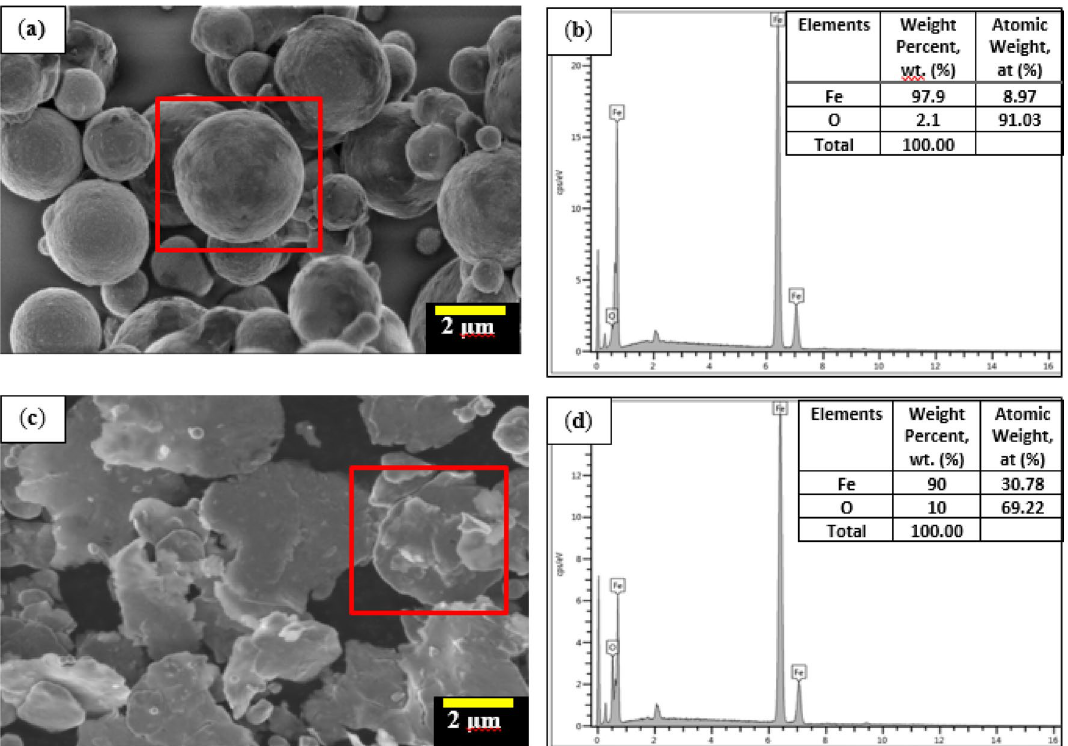
Figure 1. FESEM micrograph of non-corroded CIPs at different particle shapes; ( a ) spherical (before milling) and ( b ) EDX analysis for spherical shape, and ( c ) plate-like (after milling) and ( d ) EDX analysis for plate-like